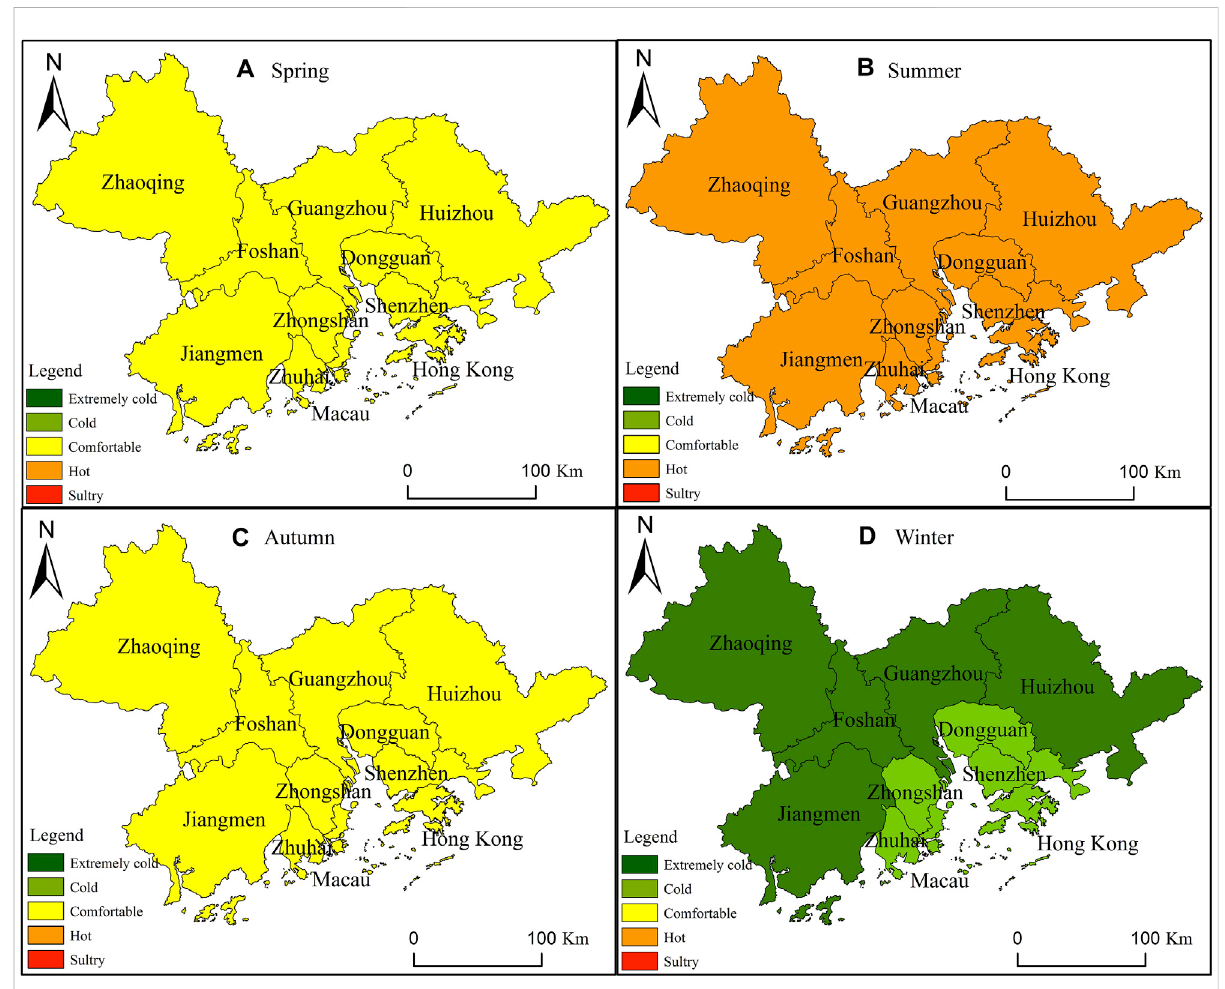
FIGURE 6 Seasonal change of climate comfort of human settlements in the Guangdong – Hong Kong – Macau Greater Bay Area in